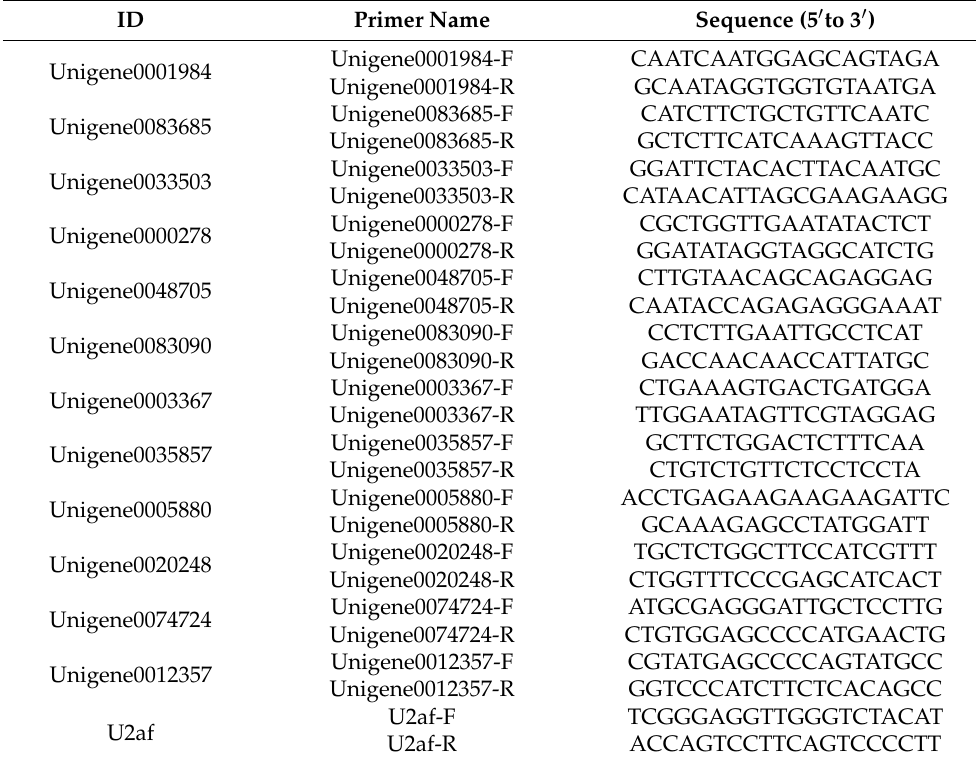
Table 2. Primers used for